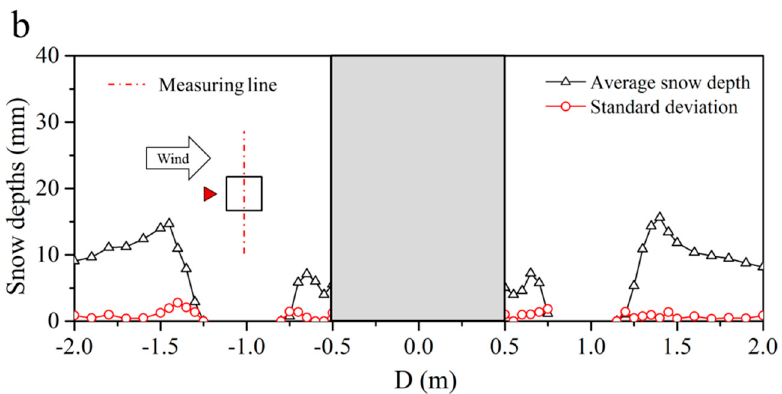
Figure 8. Results of the 20 experiments: ( a ) streamwise direction (center section) and ( b ) lateral section (center section).